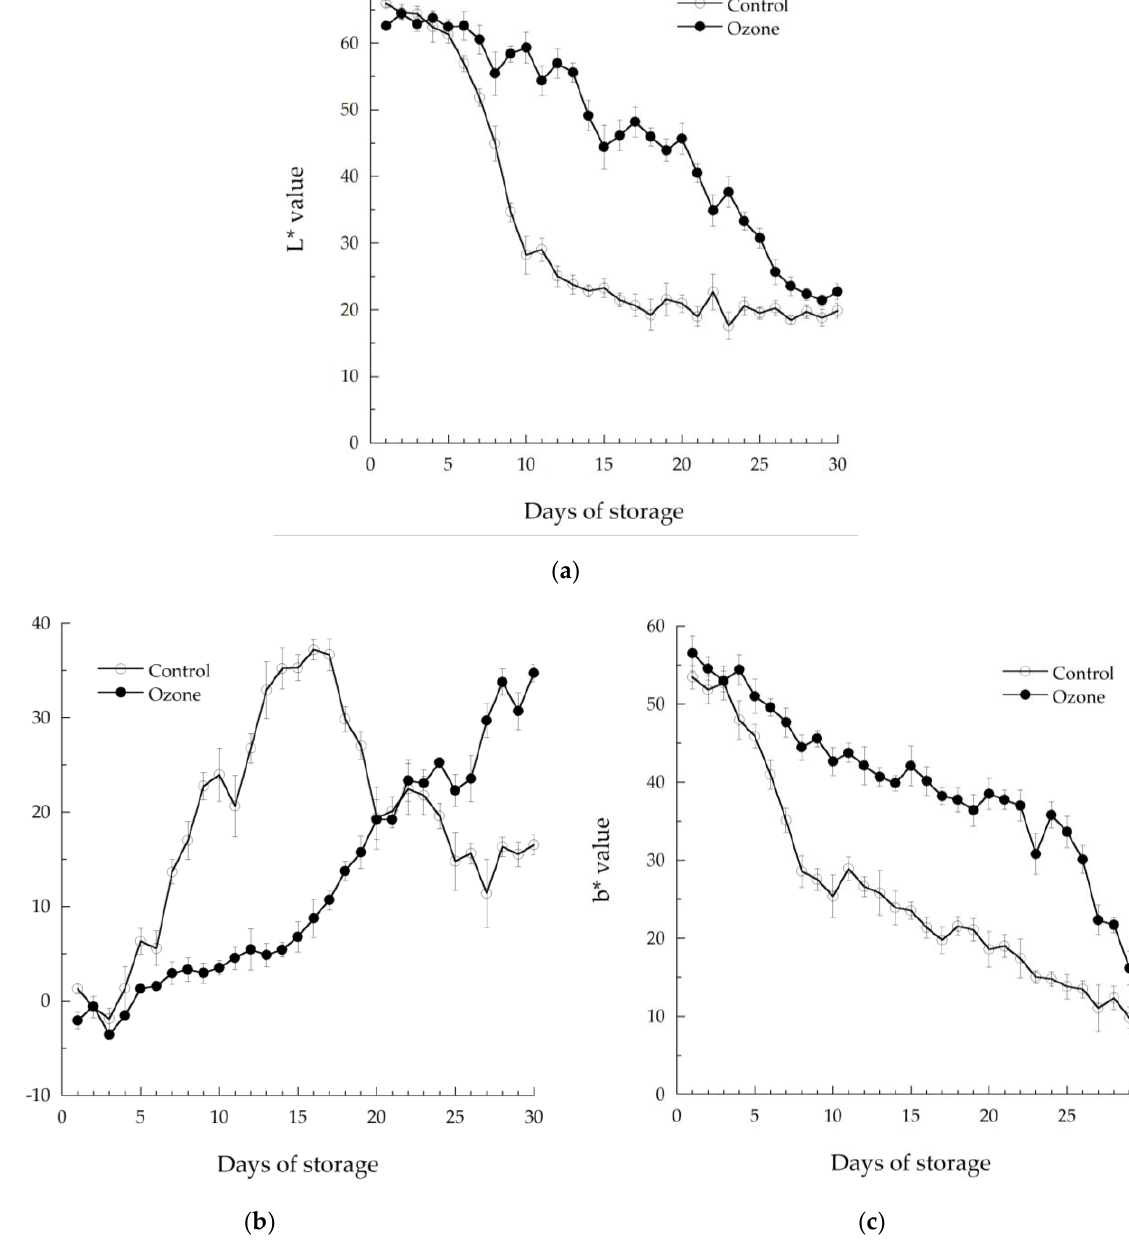
Figure 5. This showed that the treatments affected the quality of the color, namely the value of L*, a* and b* of mangosteen fruit during storage, respectively.